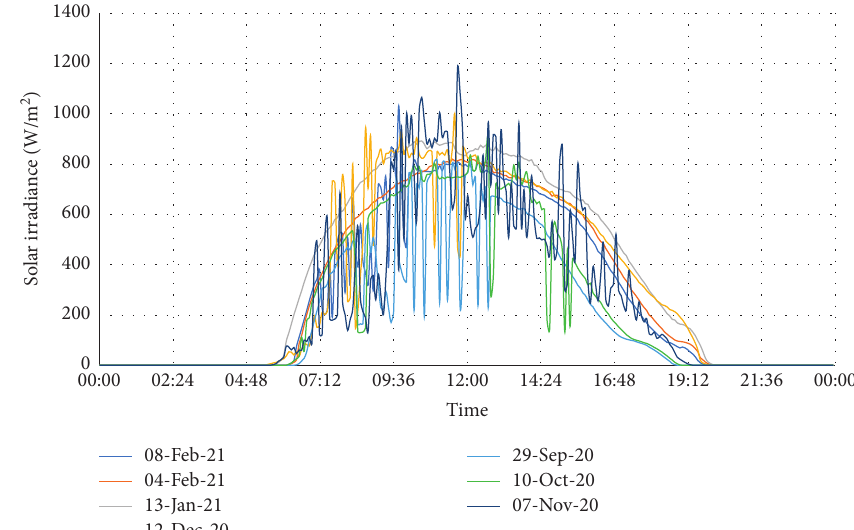
Figure 5: Solar irradiance versus